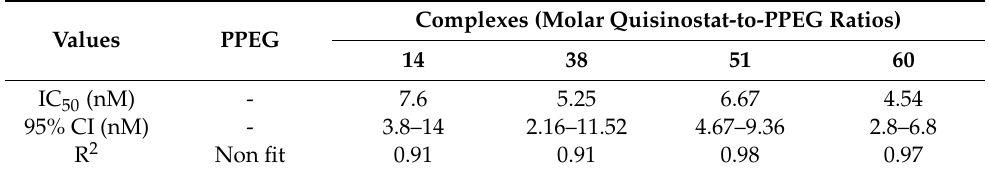
Table A3. IC 50 values of quisinostat–PPEG complexes in WM115 melanoma cells (72 h): IC 50 values calculated on the basis of complex or polymer concentrations.